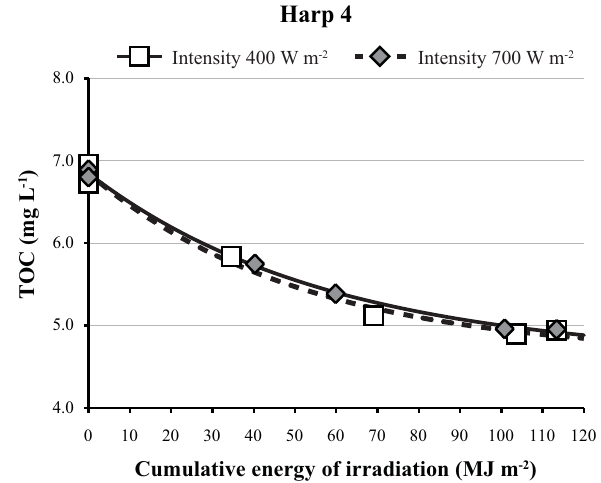
Fig. 1. The first-order kinetics equation fit with measured data at dif- ferent intensities of irradiation. Cumulative irradiation energy was calculated as a product of intensity and time of